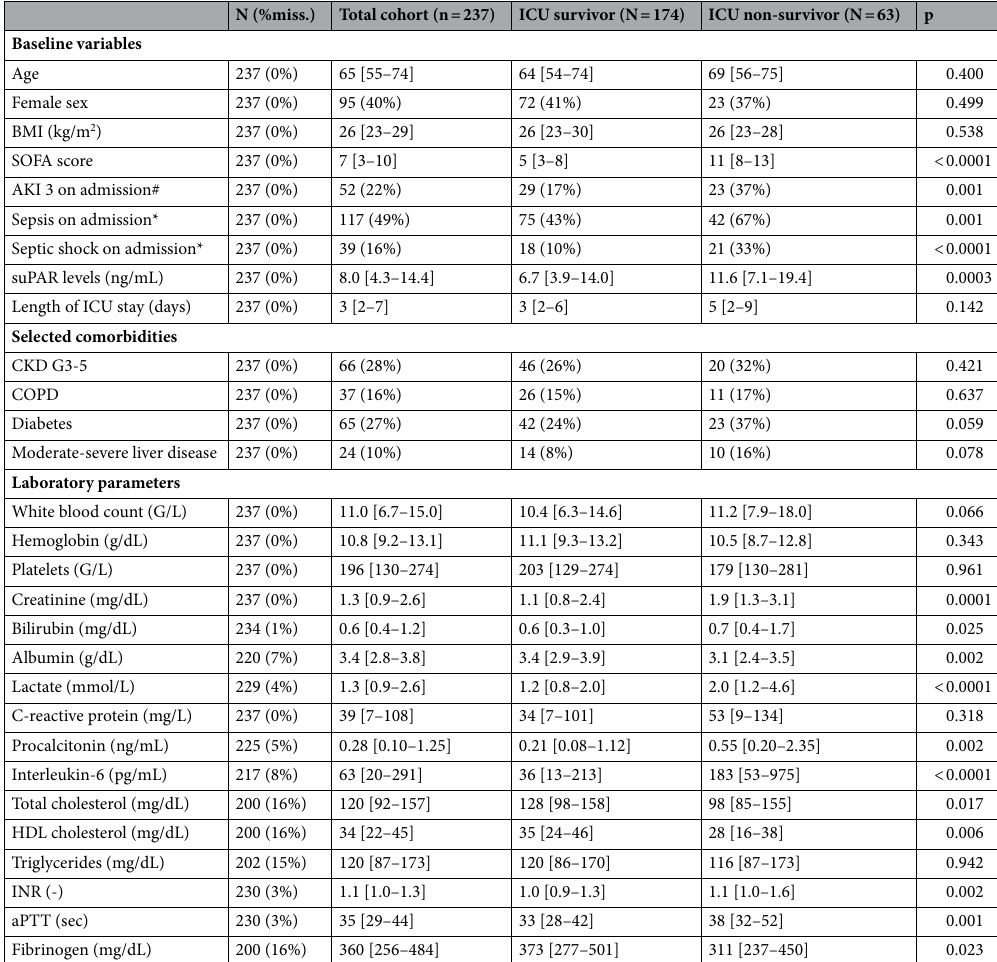
Table 1. Baseline characteristics and laboratory values. *According to sepsis-3 criteria: Sepsis is defined as SOFA score increase ≥ 2 points and suspected infection by the treating physician. Septic shock is defined as sepsis plus vasopressor therapy to maintain mean arterial pressure ≥ 65 mmHg in the absence of hypovolemia and a lactate level > 2 mmol/L. BMI = body mass index; SOFA = sequential organ failure assessment; AKI = acute kidney injury; suPAR = soluble urokinase plasminogen activator receptor; ICU = intensive care unit; CKD = chronic kidney disease; COPD = chronic obstructive pulmonary disease; HDL = high-density lipoprotein; INR = international normalized ratio; aPTT = activated partial thromboplastin time. # AKI 3 criteria were fulfilled as following: creatinine levels (31%), reduced urinary output (19%), both (40%), initiation of RRT